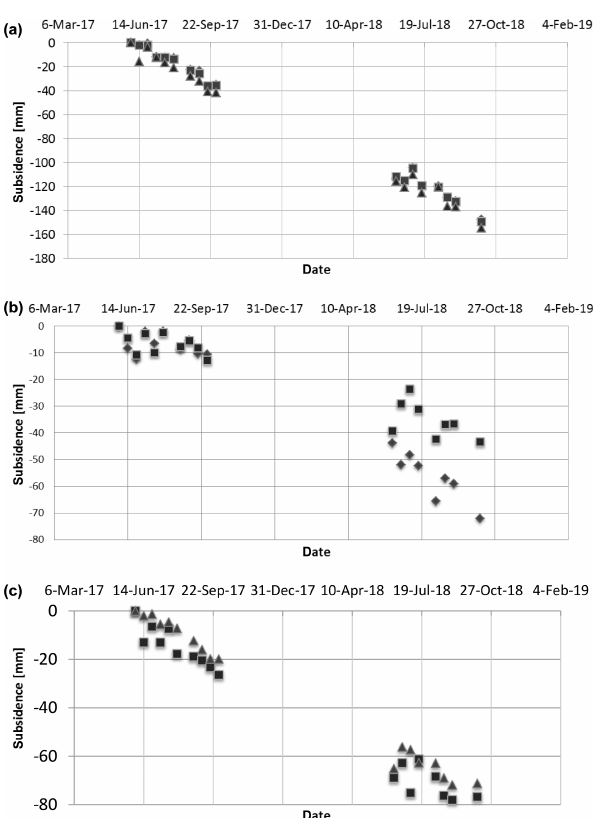
Figure 3. InSAR time-series showing gradual seasonal subsidence for A, B and C zones (Figs. 1 and 2). This analysis reveals that zone A is subsiding with higher rates relative to zones B and C.